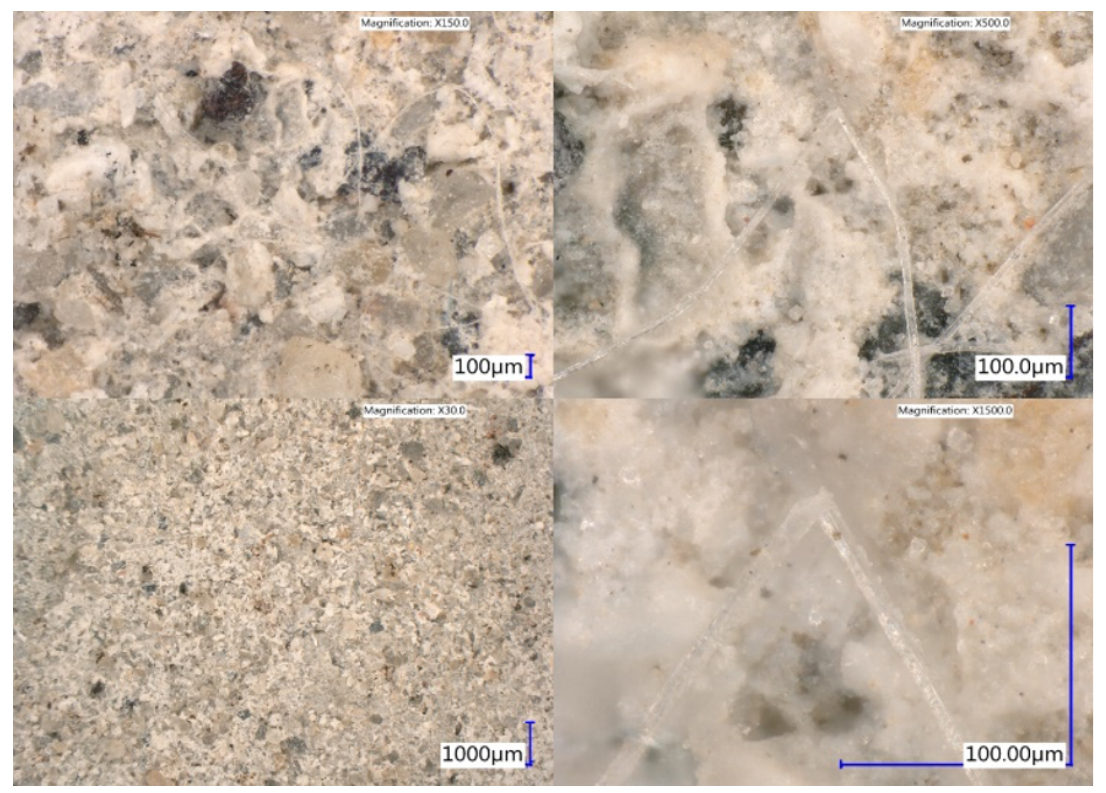
Figure 16. Optical microscope image of cement renders (PRC) at various